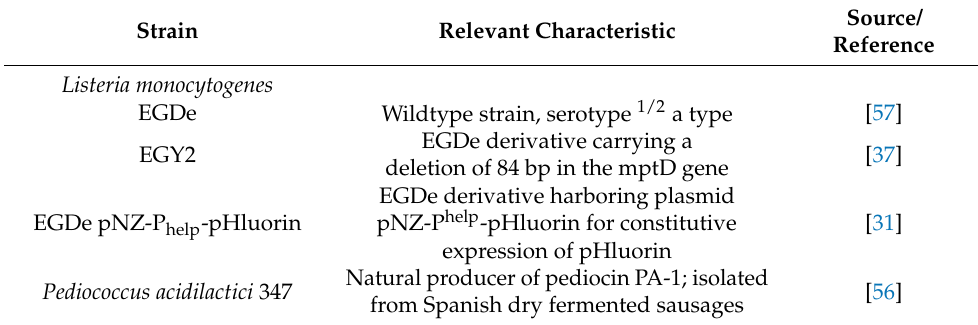
Table 2. Bacterial strains used in this study. Strain Relevant Characteristic